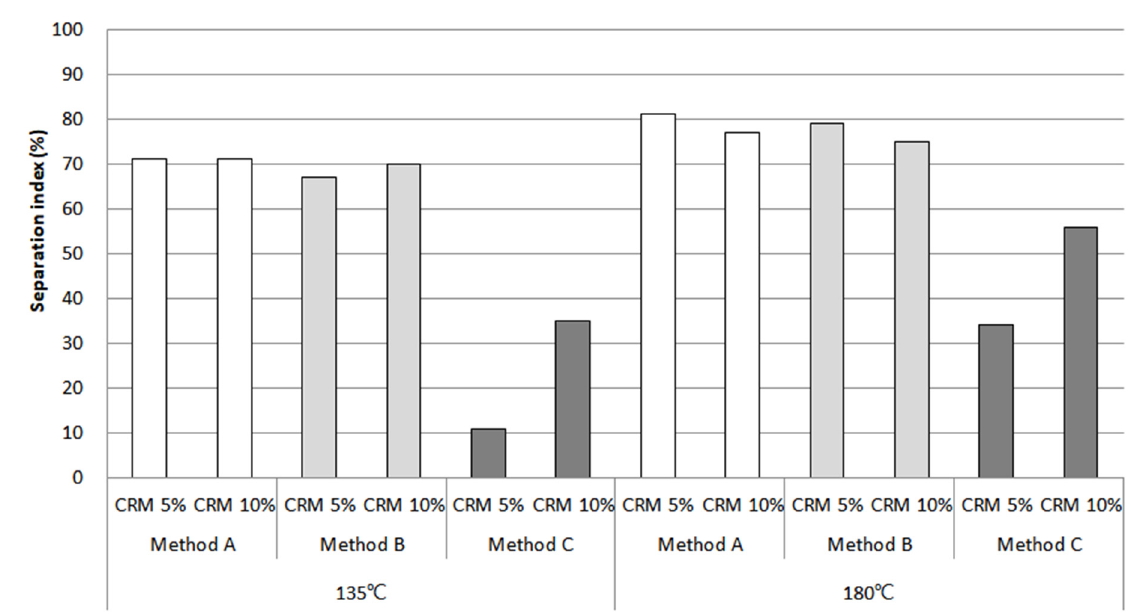
Figure 15. Separation index from rotational viscosity.